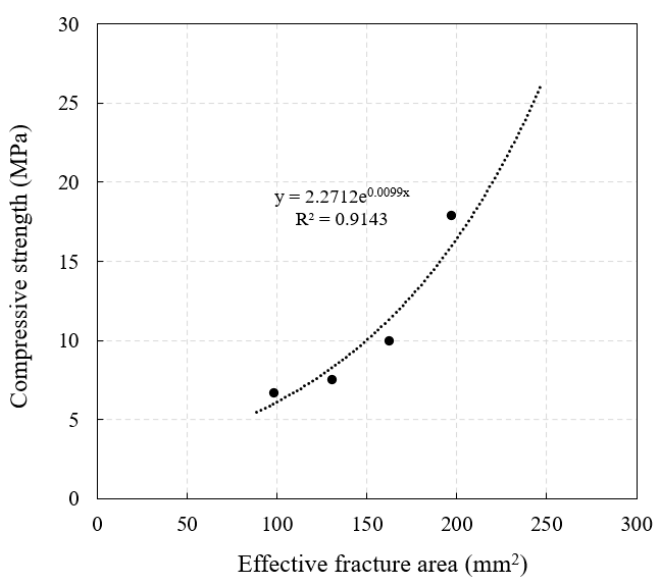
Figure 18. Relationship between compressive strength and effective fracture area.